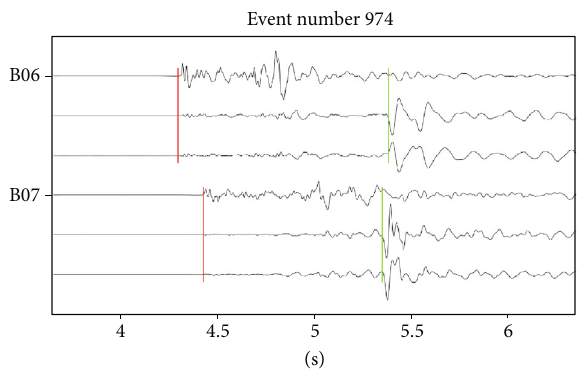
= 2 : 3 induced earthquake (July 13 th , 2011 03: 23:27 UTC) recorded at stations B06 and B07 of the Figure 5: Seismogram example of an M L Paralana seismic network. Di ff erential times between P (red) and S (green) phase onsets are not consistent with the absolute timing of the P onset indicating instrument time drift in the order of